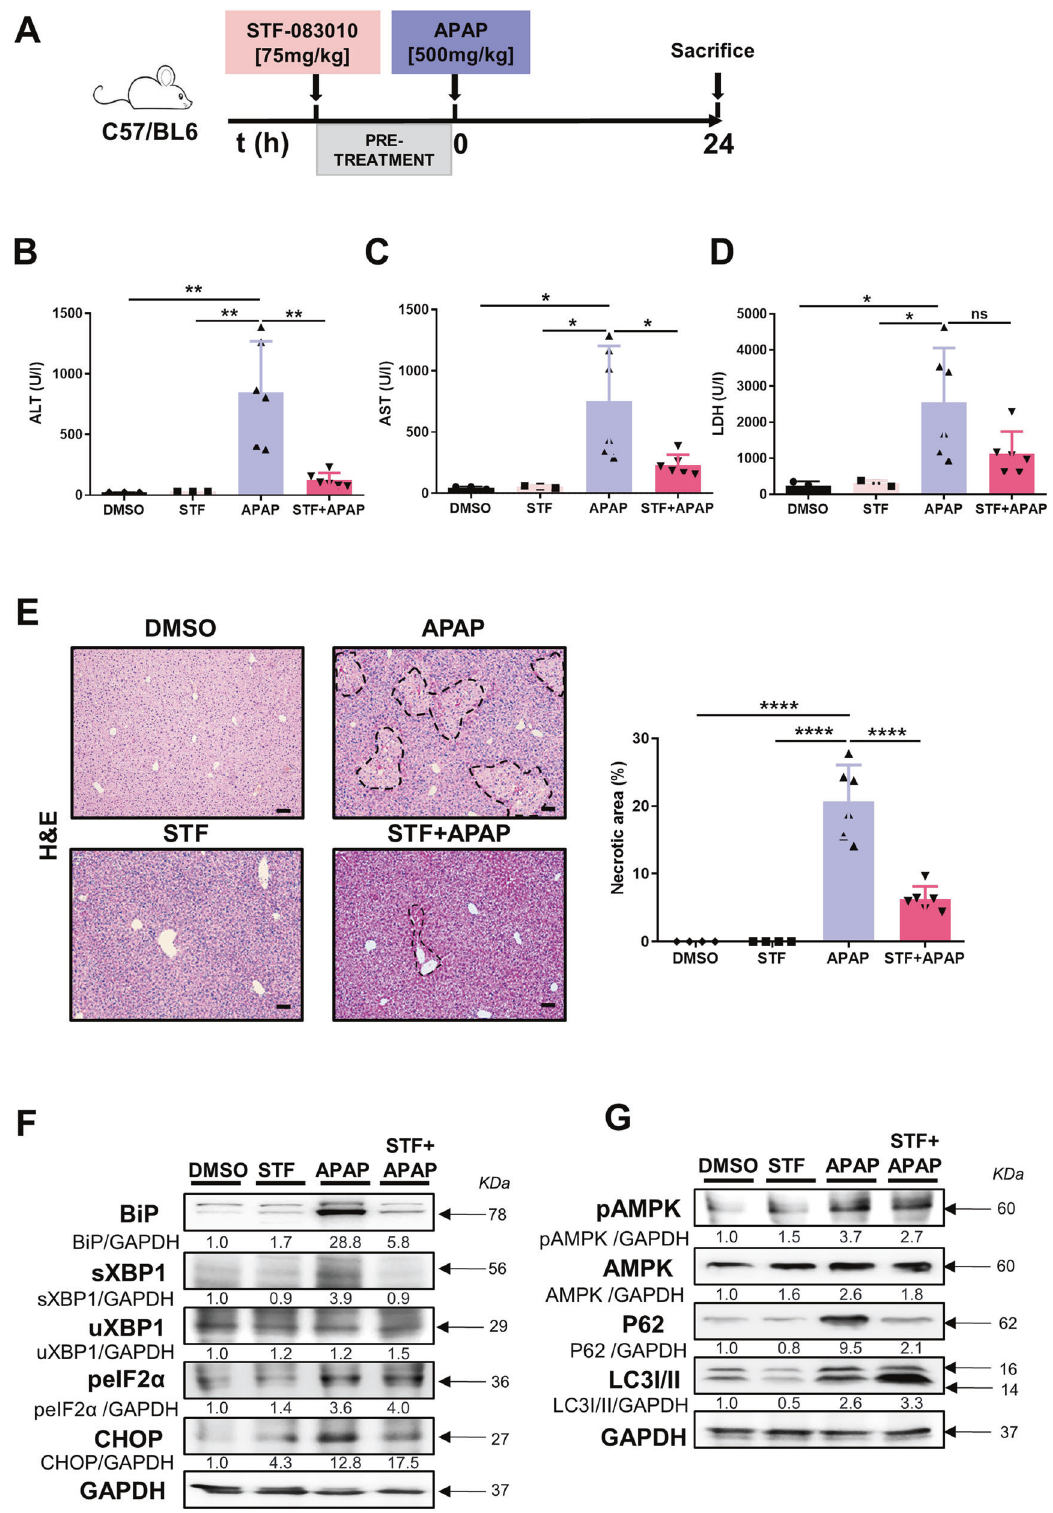
Fig. 5 Pretreatment with STF-083010 (STF) attenuates APAP-induced hepatic injury and the UPR, and promotes autophagy after challenge with APAP. A C57BL/6J mice were injected i.p. with STF [75 mg/kg] or an equal volume of PBS with 10% DMSO, 1 h before APAP [500 mg/kg] and sacri fi ced 24 h later. A control group of STF-injected mice, was included. B – D Markers of liver damage were measured and represented. Serum ALT ( B ), AST ( C ) and LDH ( D ) levels represented as U/L. E Representative H&E staining was performed in paraf fi n liver sections and necrotic foci were quanti fi ed. Scale bars, 100 μ m. F Protein levels of BiP, CHOP, peIF2 α , sXBP1, and uXBP1 were determined. G Protein levels of pAMPK, AMPK, P62, and LC3I/II were determined. Data are expressed as mean ± SEM ( N = 4 – 5 per experimental group; ** p < 0.01-**** p < 0.0001;*